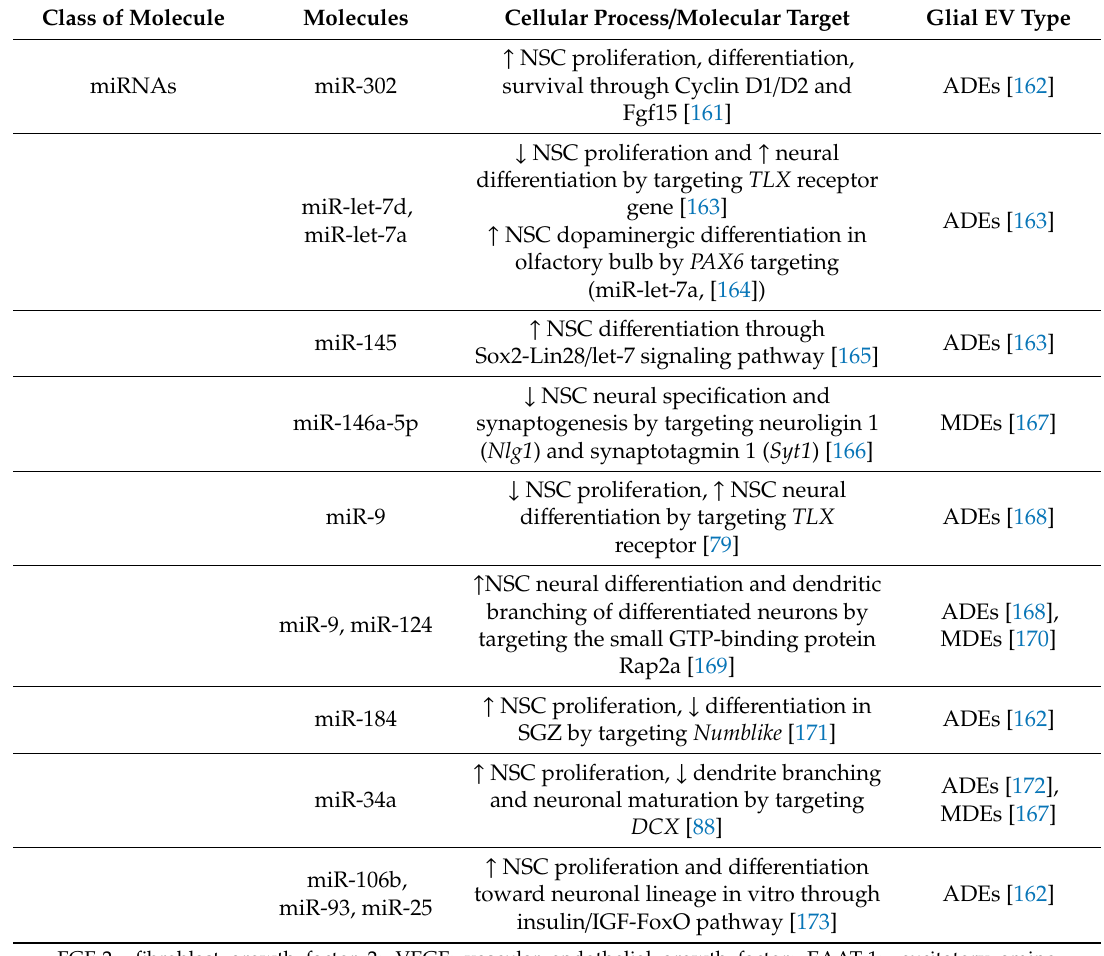
FGF-2: fibroblast growth factor 2; VEGF: vascular endothelial growth factor; EAAT-1: excitatory amino acid transporter 1; NTPDases: nucleoside triphosphate diphosphohydrolases; CD13: aminopeptidase